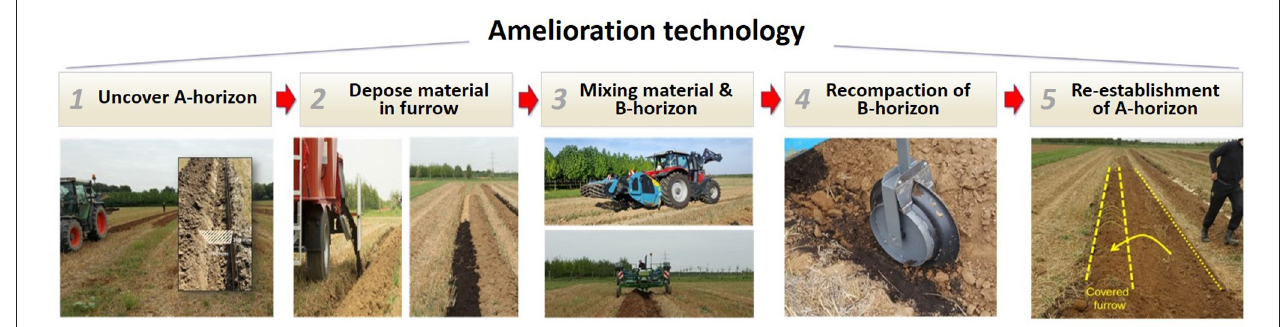
FIGURE 1 | Mechanical subsoil amelioration: the five steps of the Soil 3 method. © Oliver Schmittmann .